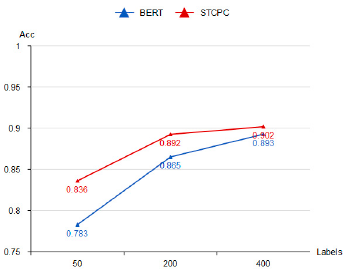
Figure 9. Sogou News dataset training results.